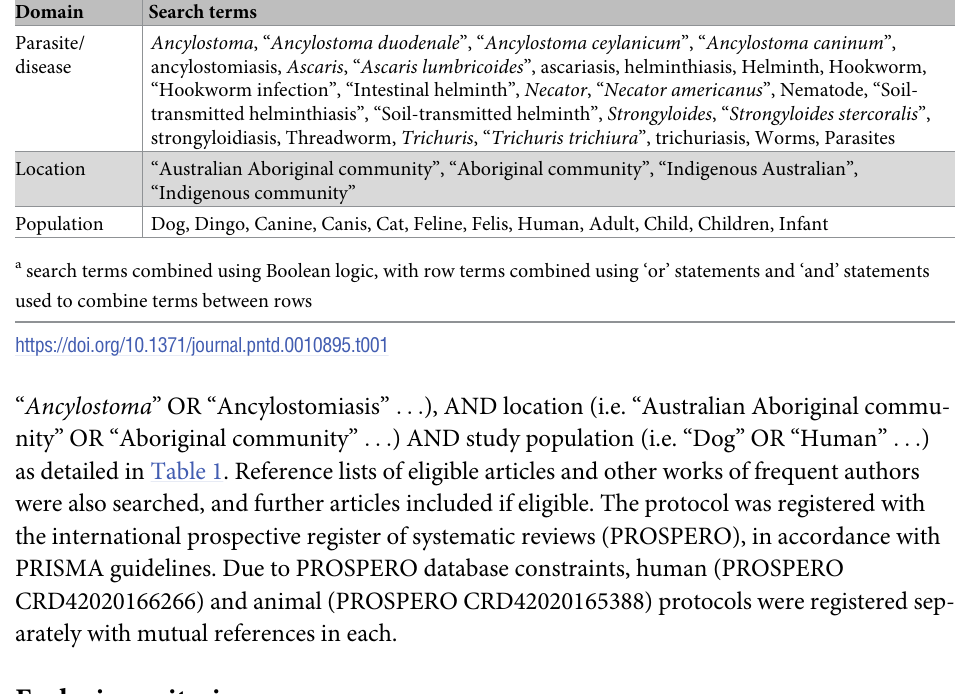
Table 1. Systematic review search terms a . Domain Search